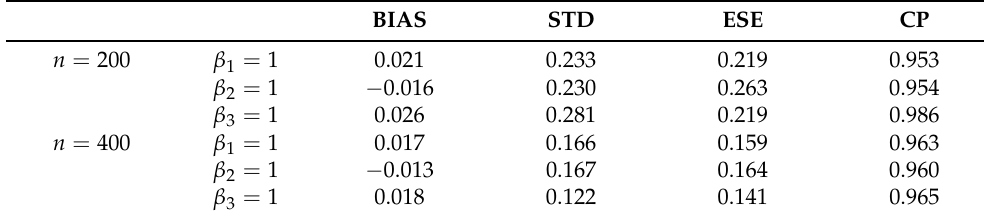
Table 1. Simulation results for ( β 10 , β 20 , β 20 ) = ( 1,1,1 ) .